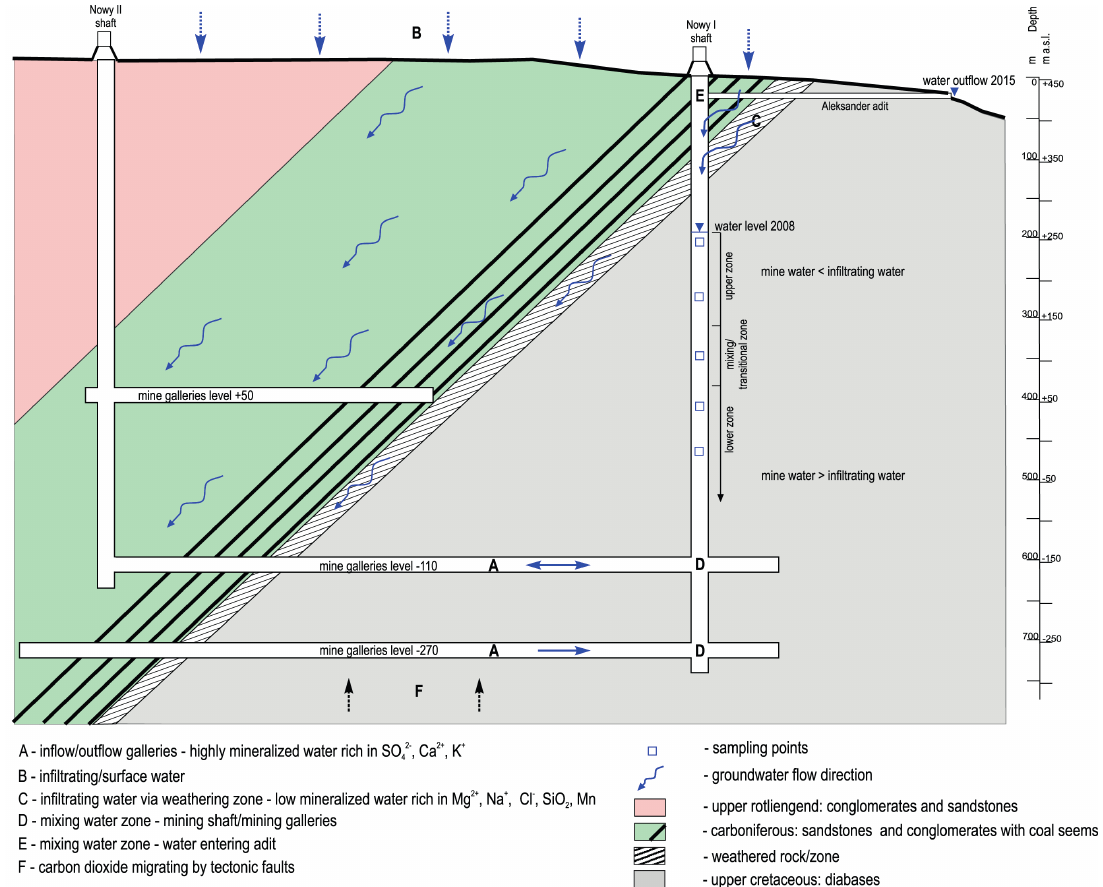
Figure 8. Conceptual scheme of water stratification in the flooded shaft “Nowy